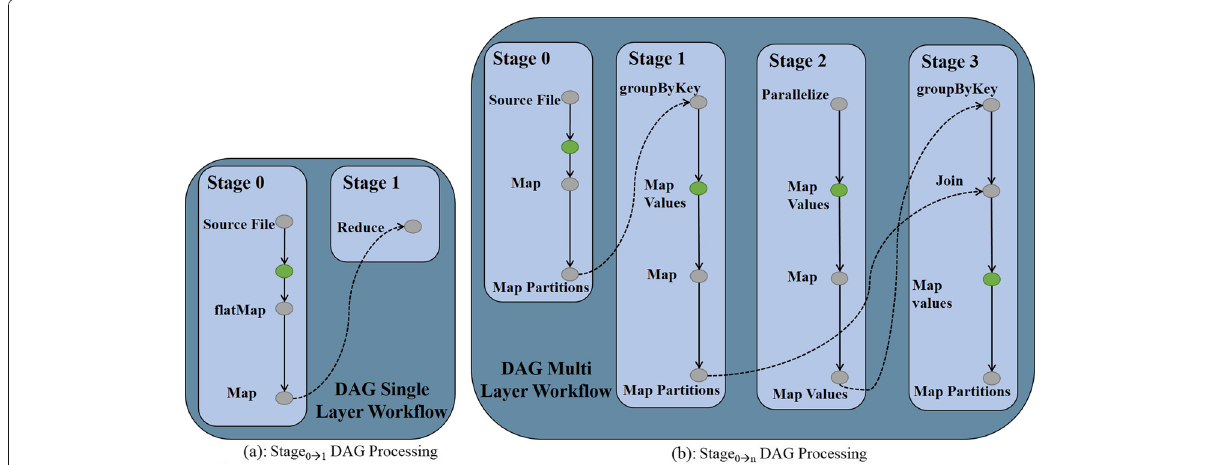
Fig. 2 Default Directed Acyclic Graph (DAG) workflow in Streaming